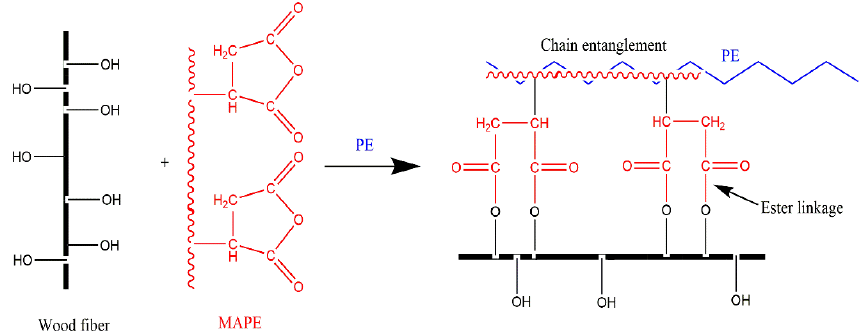
Figure 9. Schematic diagram of interaction in wood/PE/MAPE.